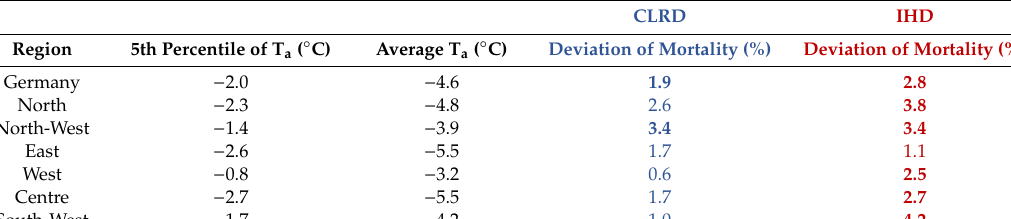
Table 4. Deviation of CLRD (blue) and IHD (red) mortality during cold waves based on T a . Significant deviations on 95% level (a < 0.5) are marked in bold.